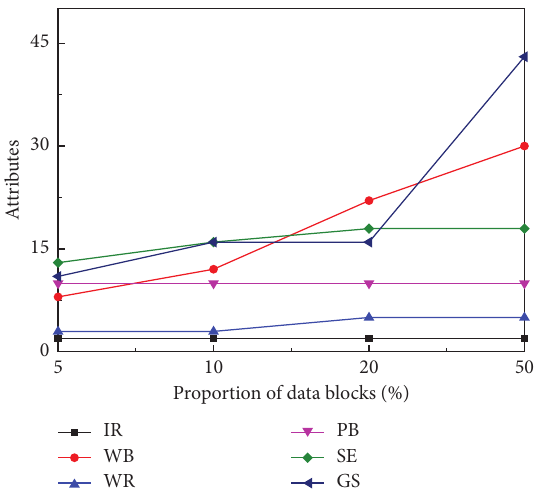
Figure 1: Feature reduction of SPFRFCM.